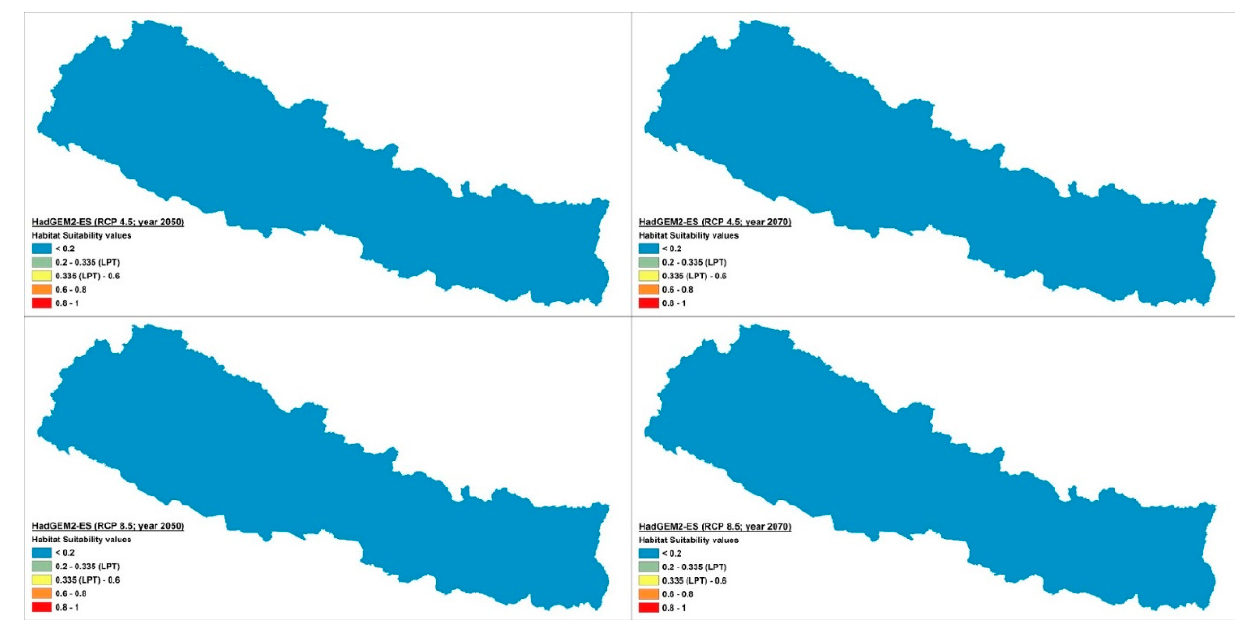
Figure 6. Climate change scenario under HadGEM2-ESmodel, RCP 4.5 and 8.5 at 2050 and 2070.